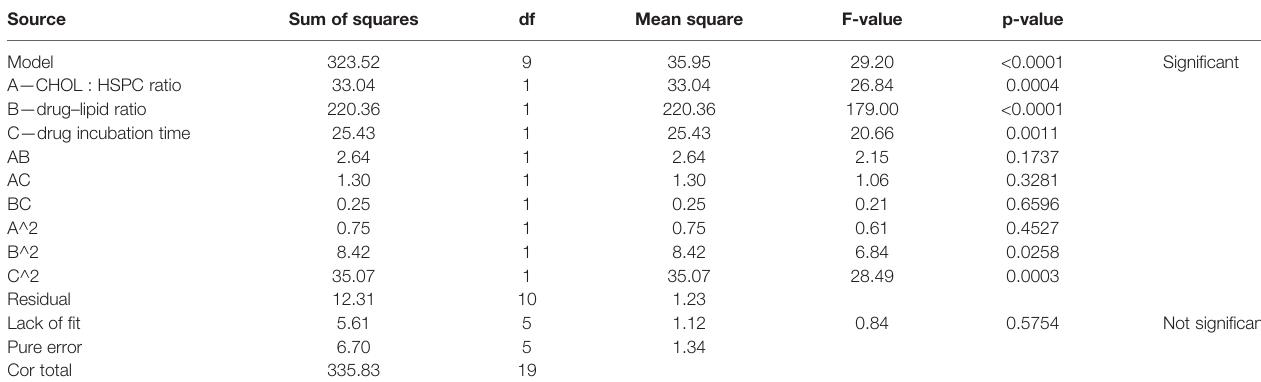
TABLE 6 | Results of variance analysis of drug loading ef fi ciency